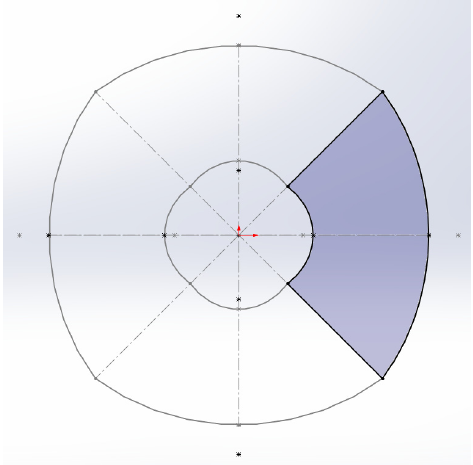
Figure 7. Representation of reachable workspace area.